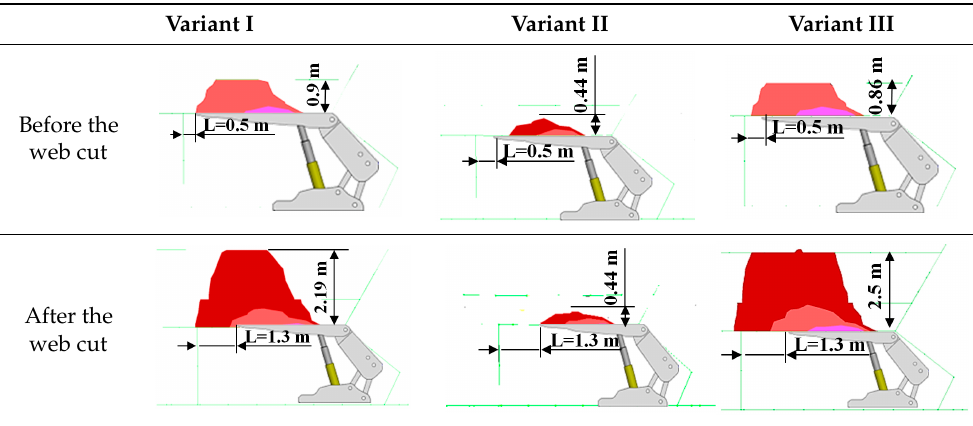
5. Table 5. Comparative analysis the simulation results of the three schemes. Table 5. Comparative analysis the simulation results of the three schemes. Table 5. Comparative analysis the simulation results of the three schemes. Table 5. Comparative analysis the simulation results of the three schemes. Table 5. Comparative analysis the simulation results of the three schemes. Table 5. Comparative analysis the simulation results of the three schemes. Table 5. Comparative analysis the simulation results of the three schemes. Variant I